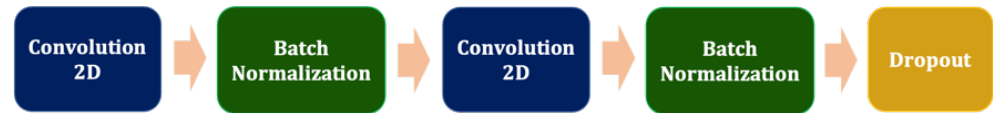
Figure 2. Basic convolutional unit used in all the model architectures.